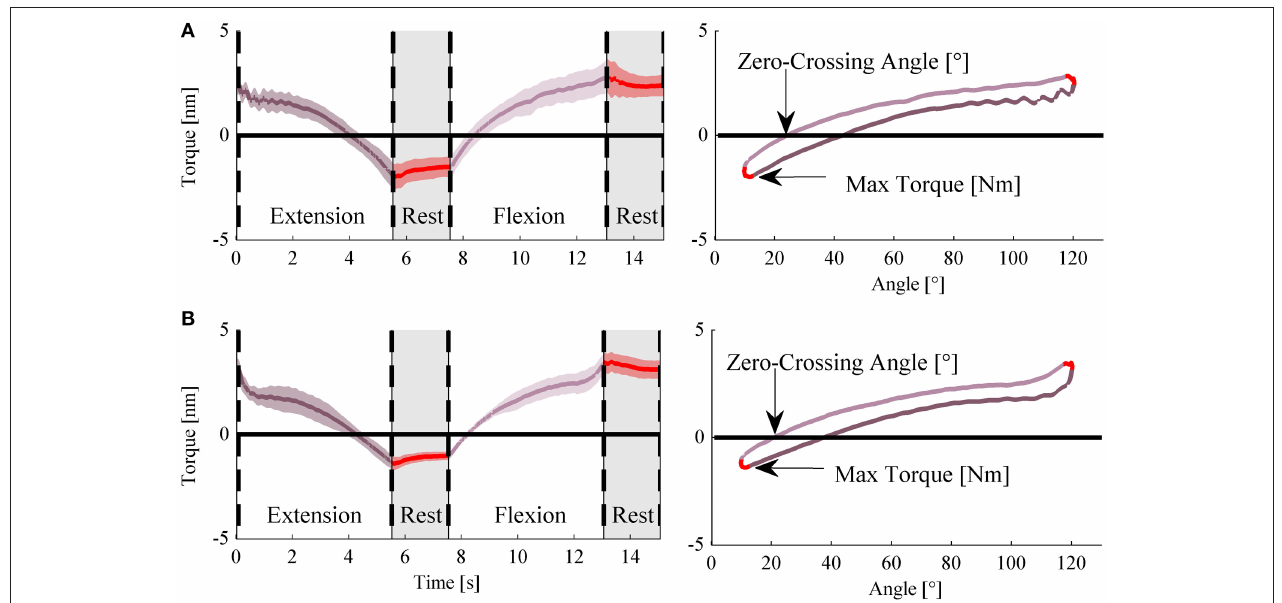
FIGURE 2 | Figure 1 NEEM measurement and indices for a representative subject. (A) Average applied torque during a flexion/extension cycle, during the first treatment session (Day #1). (B) Average applied torque and measured angle during a flexion/extension exercise, during the last treatment session (Day